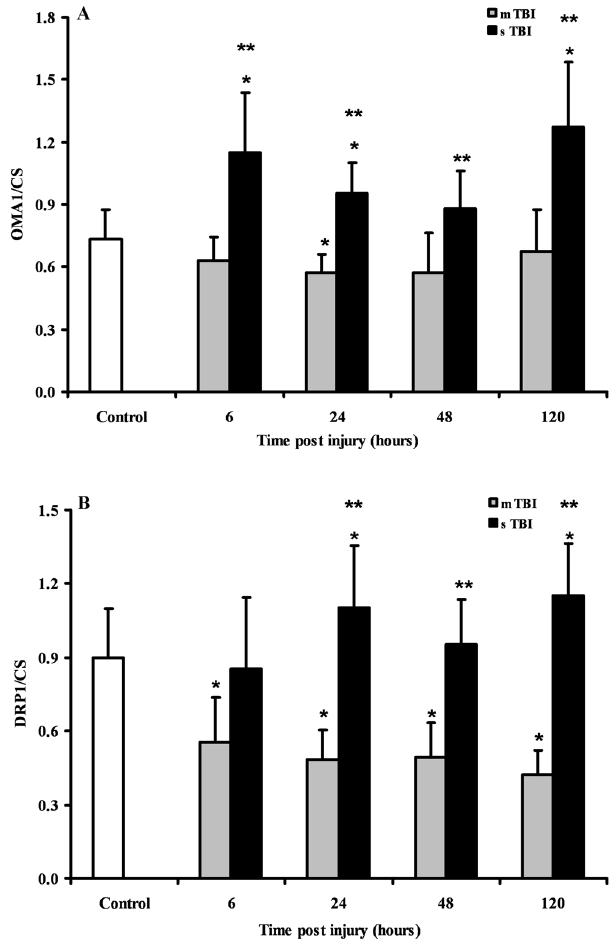
Figure 9. Semi-quantitative determination of OMA1 and DRP1 in brain tissue homogenates of rats receiving TBI of graded severity (mTBI and sTBI) at different times post-impact. Values are the mean of 6 animals. Standard deviations are represented by vertical bars. Protein expressions were calculated relatively to CS (as a mitochondrial mass indicator). * Significantly different from controls, p < 0.05. ** Significantly different from the corresponding time of mTBI rats, p <